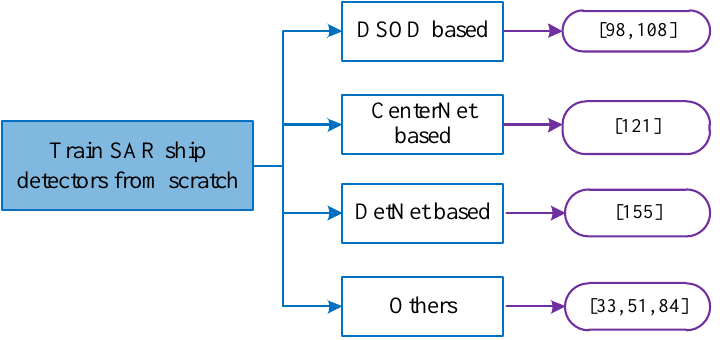
Figure 10. The detectors trained from scratch in SAR